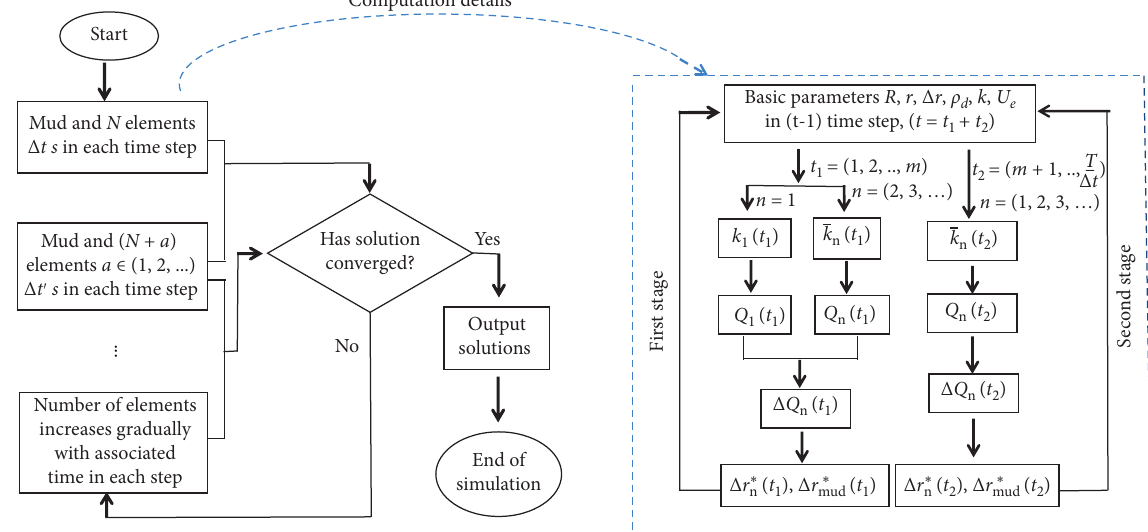
Figure 4: Flowchart of numerical solution procedure. Left: overview of the procedure. Right: computation with a certain number of elements N starting with the first time stage t